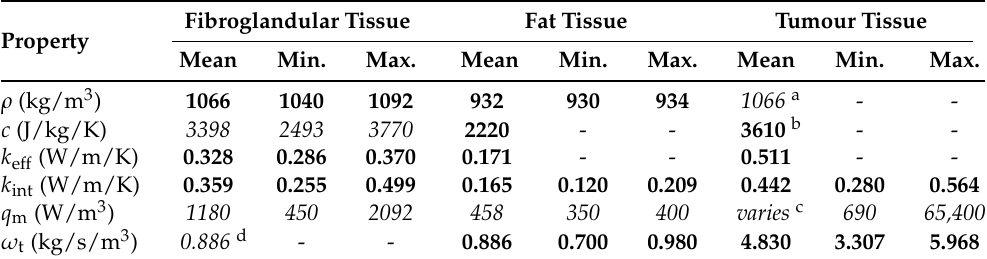
Table 8. Proposed thermal and physiological properties of healthy and cancerous breast tissues. The minimum and maximum values of the mean values are also